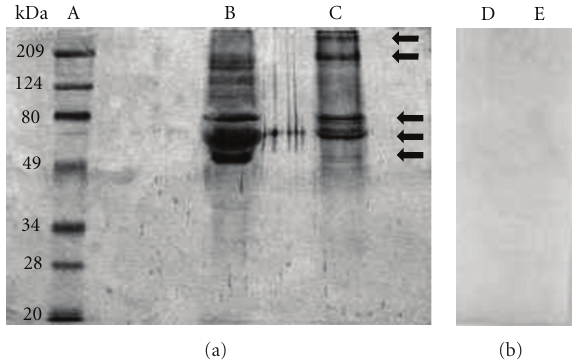
Figure 2: Western blot analysis of sodium dodecyl-polyacrylamide gel electrophoresis-separated ESEAs: Au and RG1 T. cruzi isolates. (A) standard, (B) RG1 isolate, and (C) AU isolate . The dot was probed with a pool of sera from patients with Chagas disease (B and C) and with a pool of control-negative sera RG1 and Au isolate, (D and E),